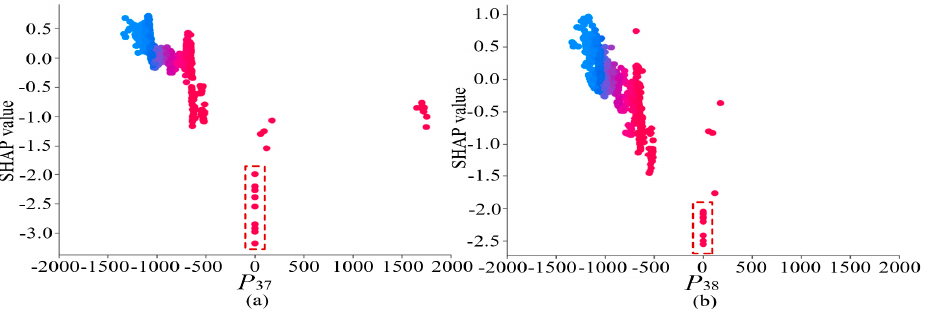
Figure 9. ( a ) SHAP dependence of P 37 ; ( b ) SHAP dependence of P 38 . The red square means the risk of transient instability is high when the value of P37 or P38 is 0.